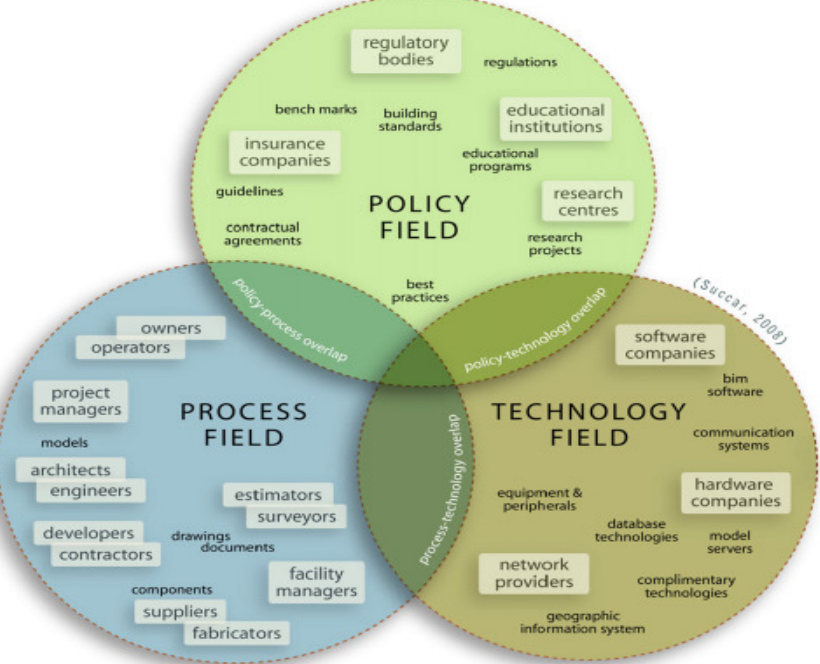
Fig. 3. Three interrelated fields of BIM (Succar